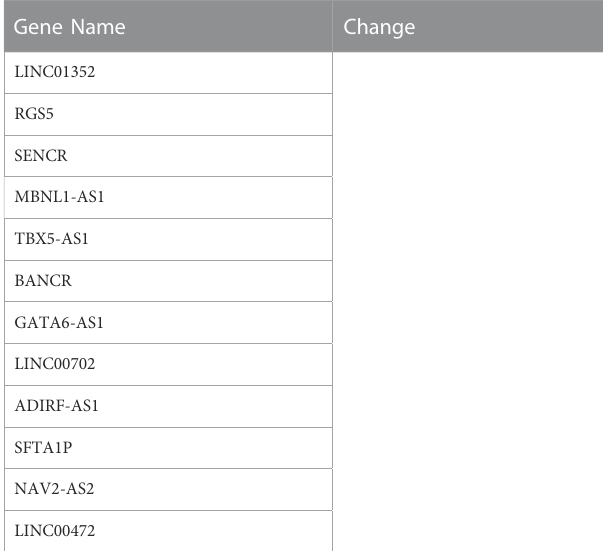
TABLE 1 List of 50 LUAD-related